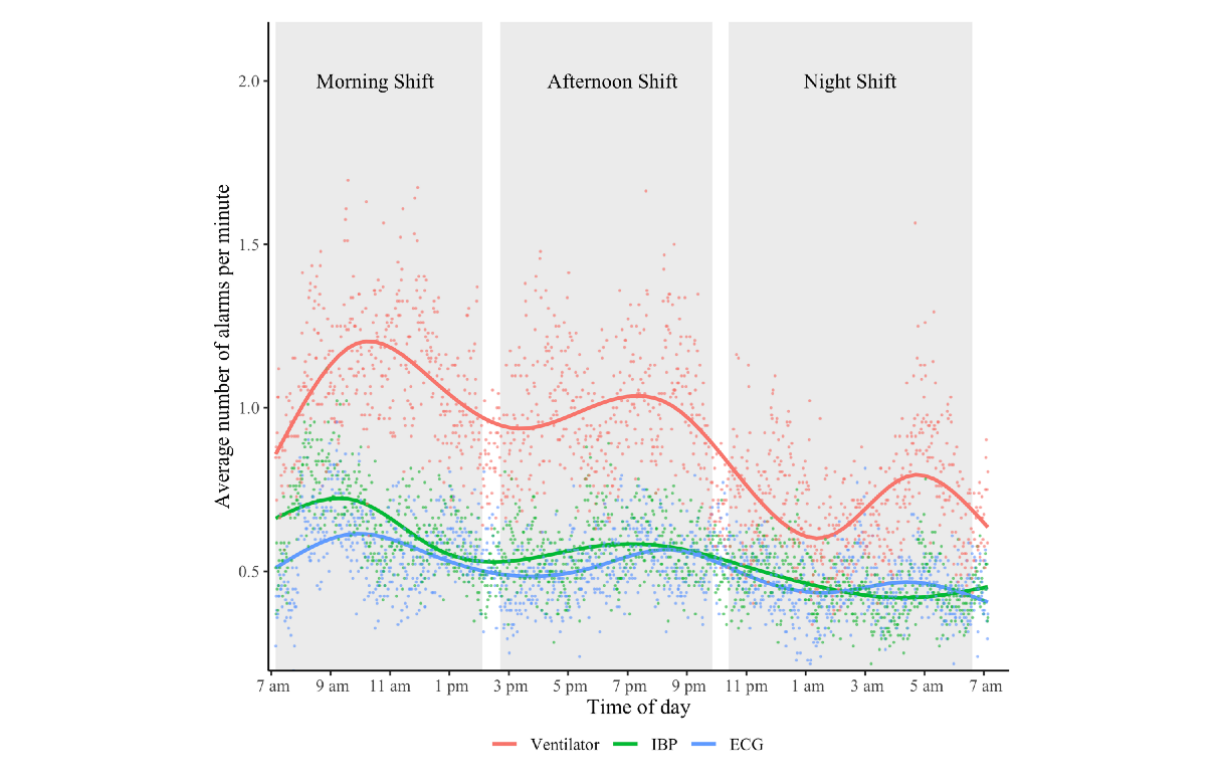
Figure 4. Average distribution of alarms across 24 hours. The white spaces between the grey bars (ie, shifts) visualize handover periods. Each dot shows the average alarm frequency of 1 minute for the specified device. The line for each device is calculated by ggplot2’s smoothing function and represents a generalized additive model of the distribution (with the formula y ~ s(x, bs = "cs"). It serves to aid in detecting trends in the data. ECG: electrocardiogram; IBP: invasive blood